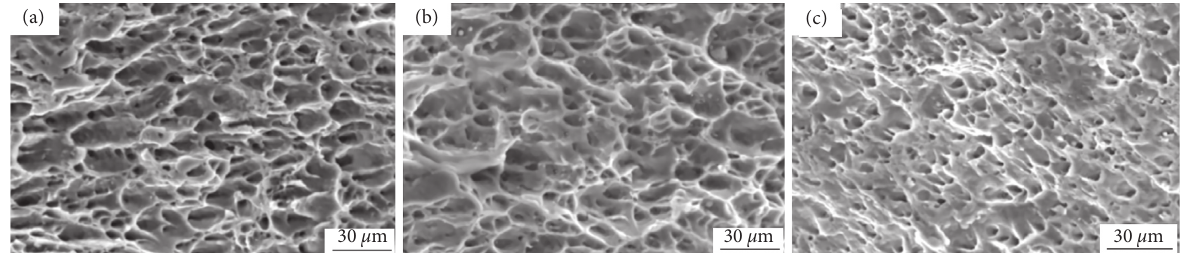
Figure 9: Fracture images of samples compressed with strain rates of (a) 0.01s − 1 , (b) 0.1s − 1 , and (c) 1s − 1